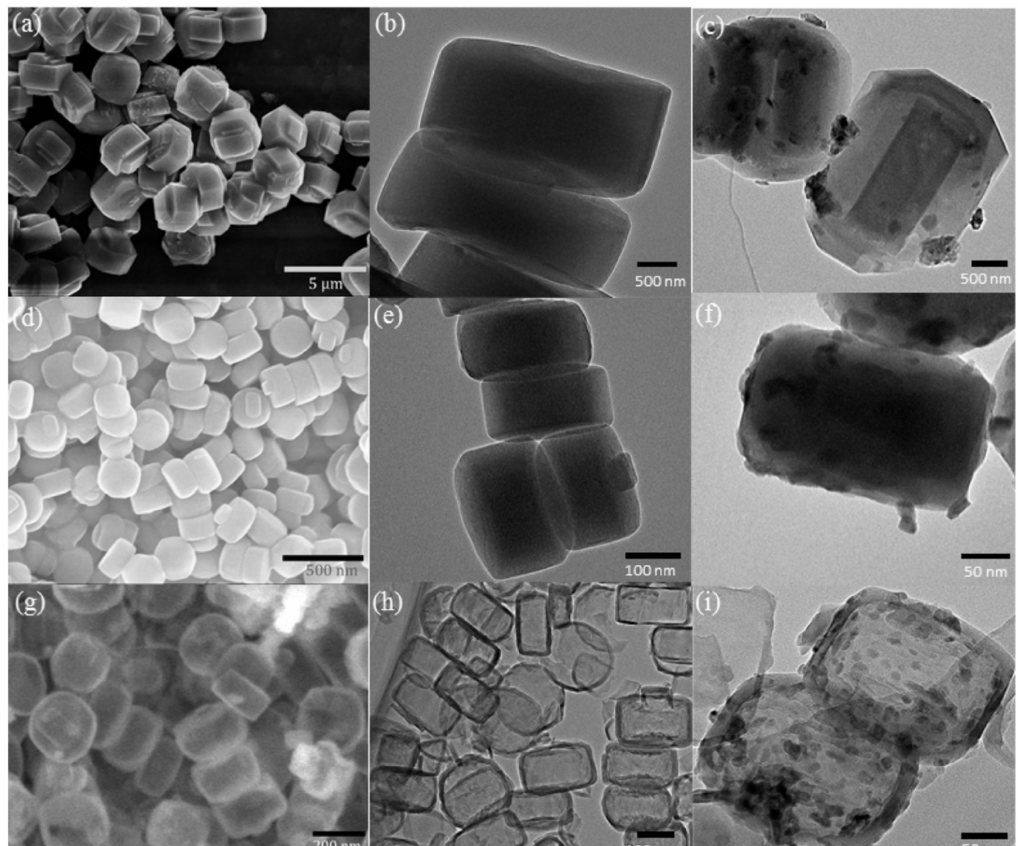
Figure 28. SEM images of zeolitic supports ( a ) M-Z5, ( d ) N-Z5, and ( g ) H-Z5, TEM images of the supports and supported catalysts: ( b ) M-Z5 ( c ) MnOx/M-Z5, ( e ) N-Z5, ( f) MnOx/N-Z5, ( h )H-Z5, and ( i ) MnOx/HZ-5. Reproduced with permission from Reference [173]. Copyright (2019) Elsevier B.